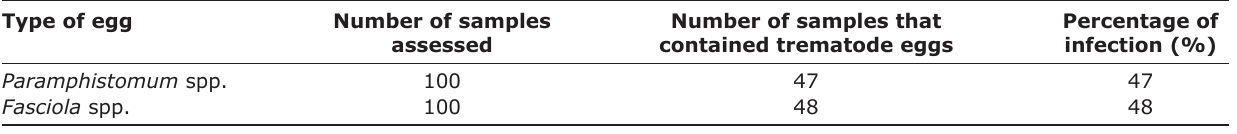
Number of samples that assessed contained trematode eggs